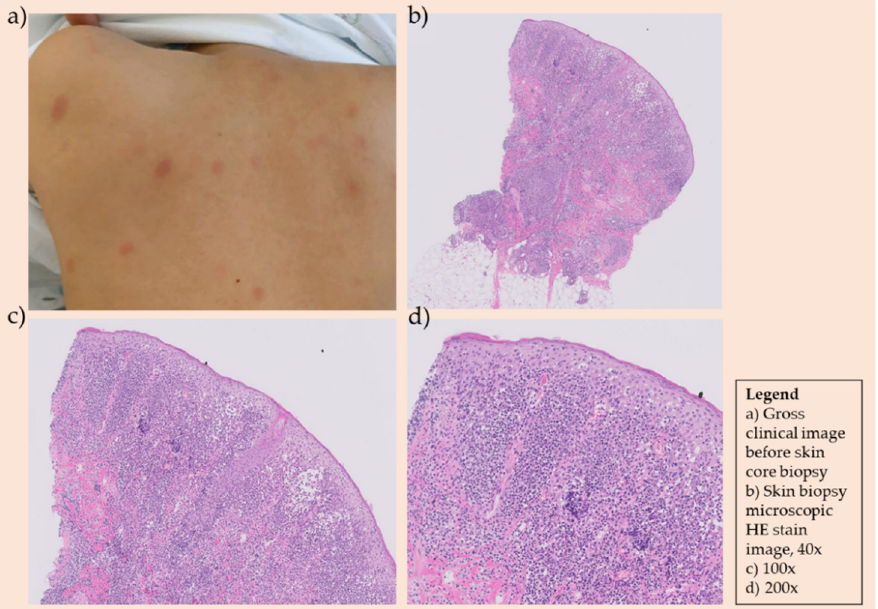
Figure 3. ( a ) The patient developed large macular coin-like raised skin lesions, 2–3 lesions on the scalp, several lesions on the trunk, and 2–4 lesions on each of the four extremities. ( b – d ) Skin biopsy showing atypical lymphoid infiltration and further immunohistochemistry stain revealing CD3+, CD5-, CD10-, CD20-, CD34-, CD99+, cyclin D1-, Ki-67 60%, TdT-, Pax-5-, with the final pathologic diagnosis as Malignant lymphoma, T-cell lymphoblastic leukemia/lymphoma